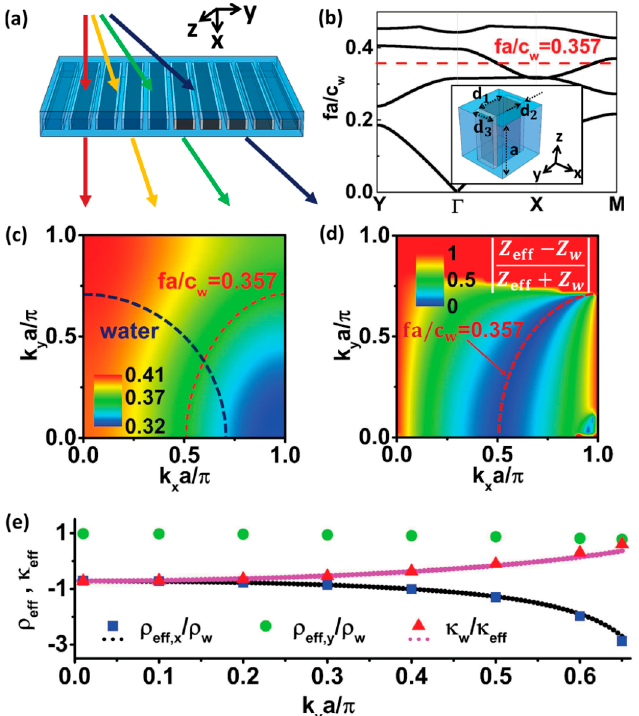
Figure 13. ( a ) Schematic of a 2D impedance-matched acoustic matching layer. ( b ) Band structure where the red dashed line denotes the central frequency f a / c w = 0.357 and inset showing the unit cell. ( c ) The equal-frequency contour of the third band. The red and blue dashed lines denote the equal frequency contours of the acoustic matching layer and water at f a / c w = 0.357, respectively. ( d ) Impedance di ff erence between the acoustic matching layer and water. ( e ) E ff ective parameters ρ ef f and K ef f of the 2D acoustic matching layer. Reprinted with permission from [309], DOI: https: // doi.org / 10.1103 / PhysRevMaterials.2.045201, Copyright (2018) by the American Physical Society.